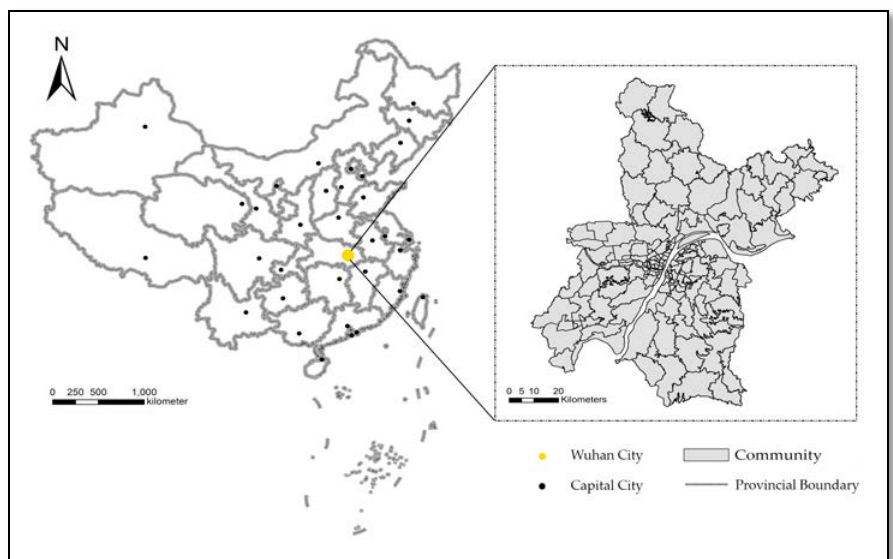
Figure 1. Wuhan’s geographical location and community boundaries.